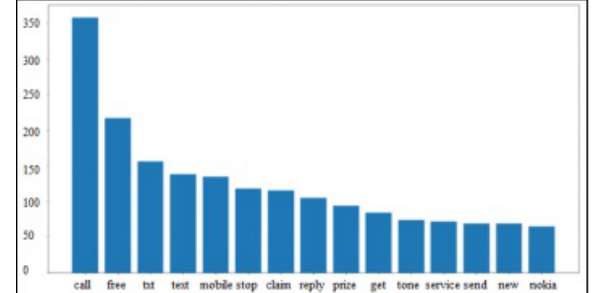
Fig. 3. Most Frequent Words in Spam messages with their